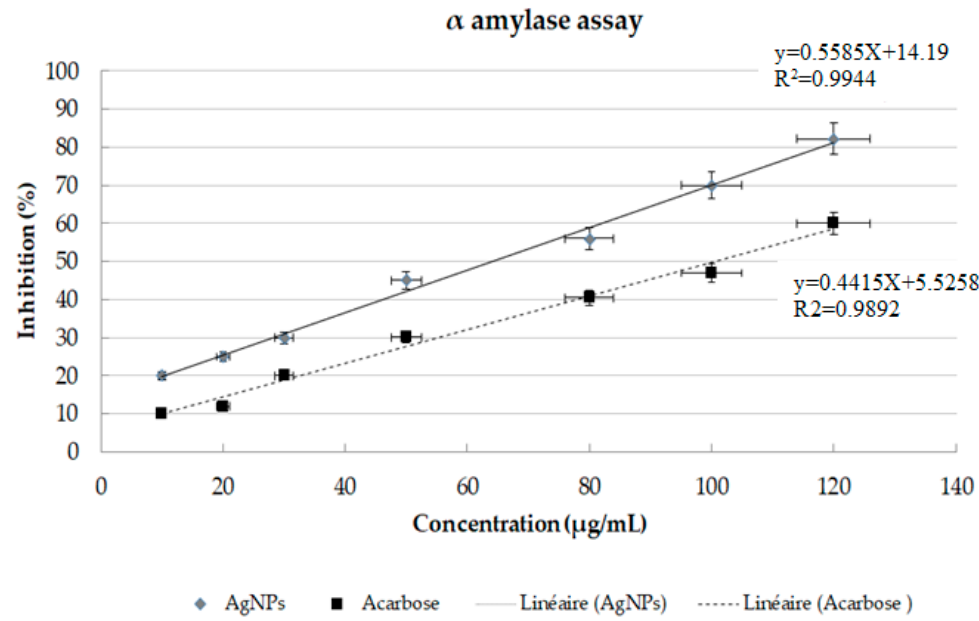
Figure 5. α amylase inhibitory effect of the AgNPs from Aeronium harworthii compared to the positive standard (Acarbose) used at 10 to 120 µg/mL. Values expressed as a percentage of inhibition. Error bars represent SE of the mean (n = 3) with a significant difference at P < 0.05.